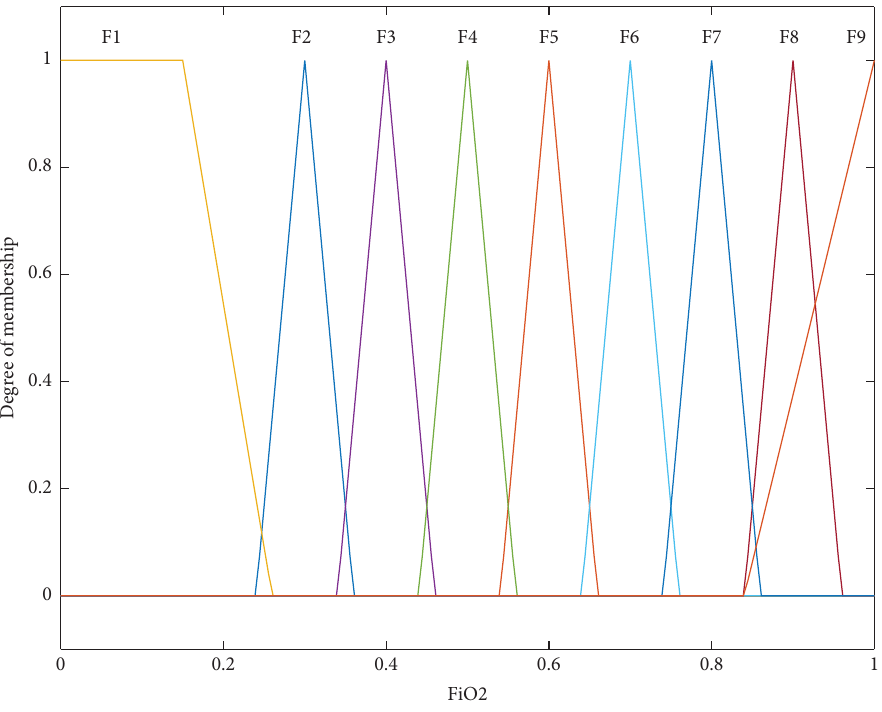
Figure 9: Membership function for FiO